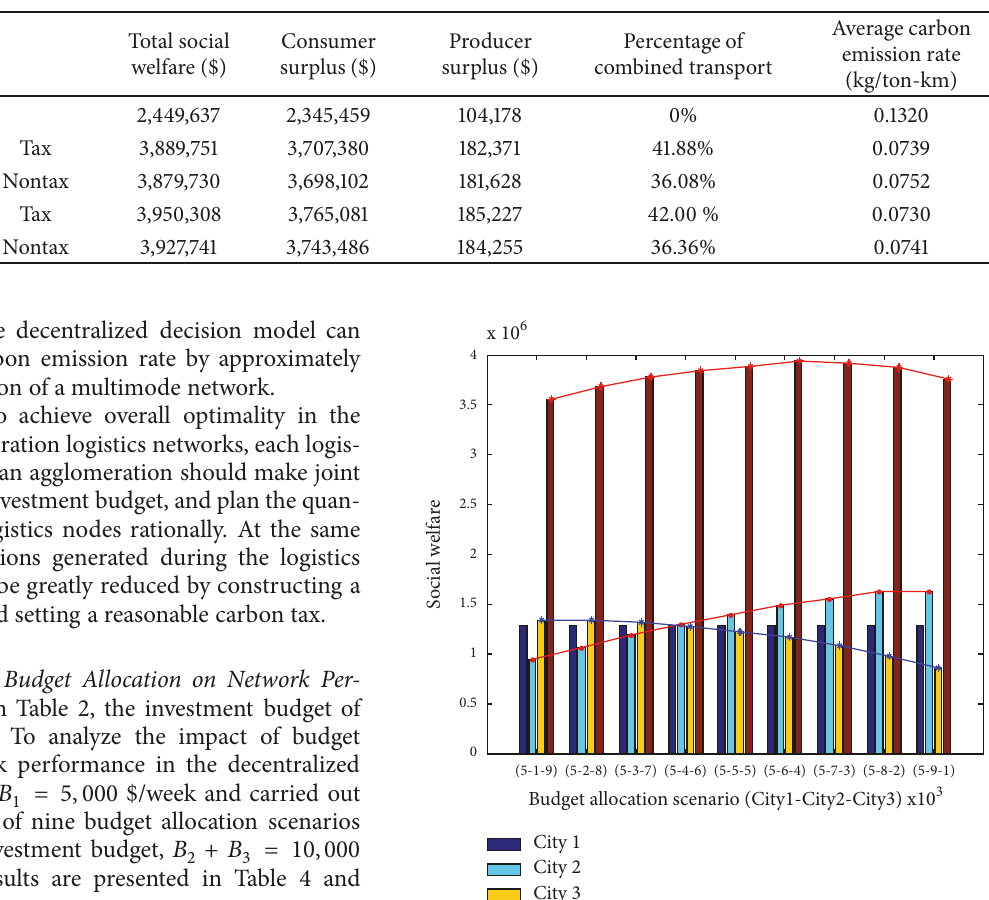
Table 3: Comparison of the three logistics network design model performances.